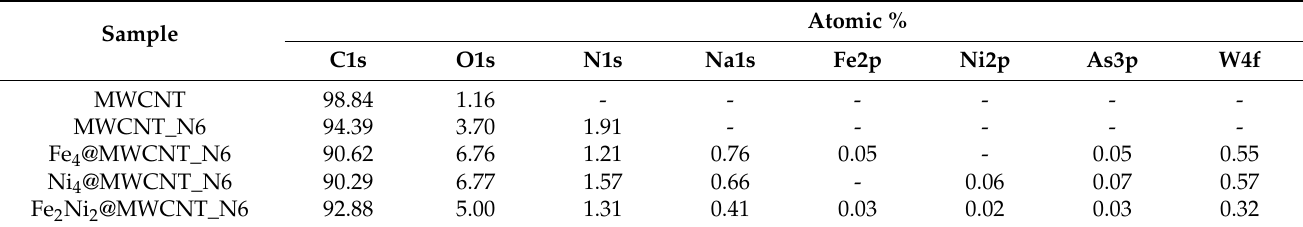
Table 1. XPS relative surface atomic percentages for all the materials a .